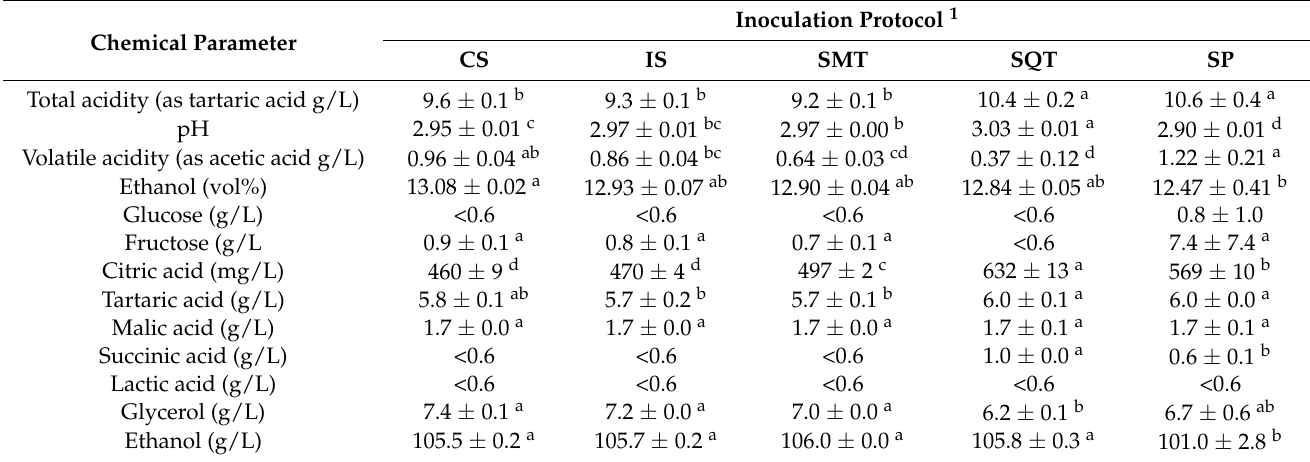
Table 3. Chemical parameters of wines produced in microvinifications (mean ± SD, n = 3). Values not sharing a letter are significantly different ( p < 0.05).